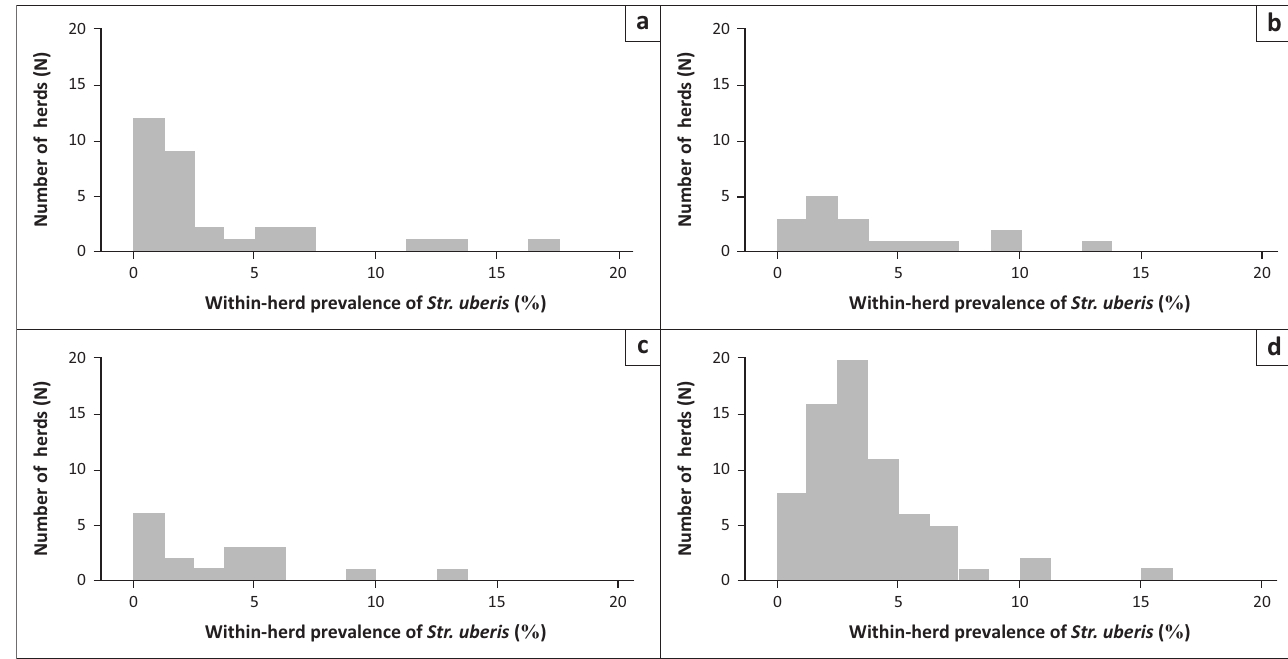
Str., Streptococcus. FIGURE 2: Distribution of the within-herd prevalence of Streptococcus uberis ( % ) for (a) total mixed ration 2008, (b) total mixed ration 2013, (c) pasture 2008 and (d) pasture 2013.